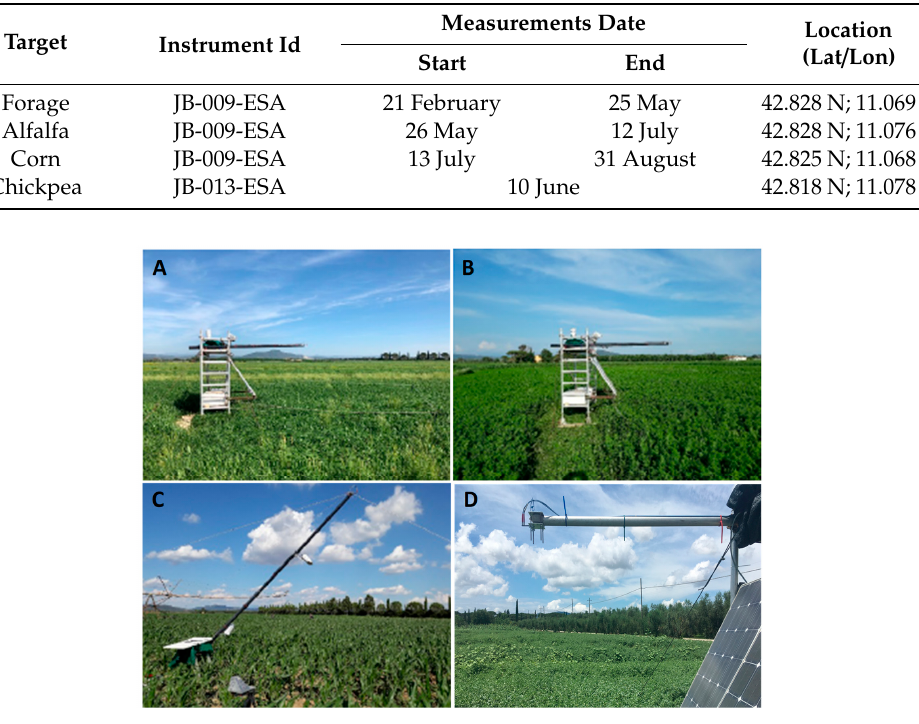
Figure 6. Field measurement set-up over the different targets investigated: ( A ) forage; ( B ) alfalfa; ( C ) corn; ( D ) chickpea. ( C ) corn; ( D )